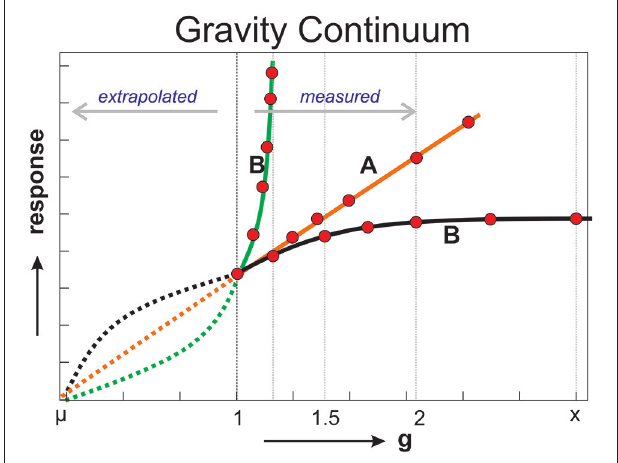
FIGURE 6 | Cartoon of the Gravity Continuum. The red dots represent measurements at various hyper-g values. Connecting lines based on the measurements (solid) can be extrapolated (dotted lines) to lower g